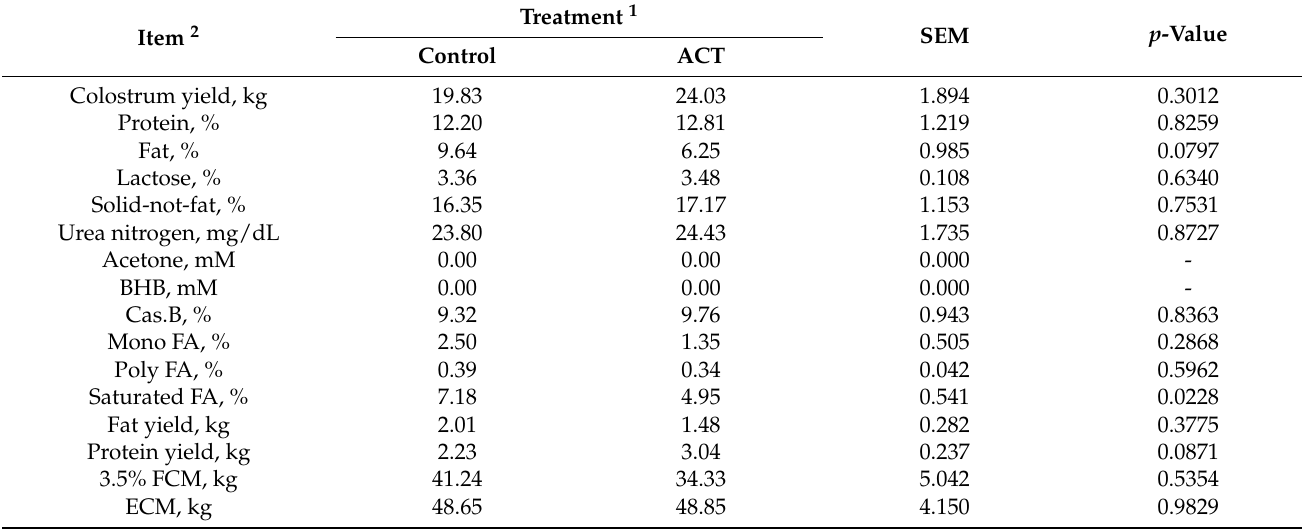
Table 5. Impact of ACT on colostrum yield and composition in cows